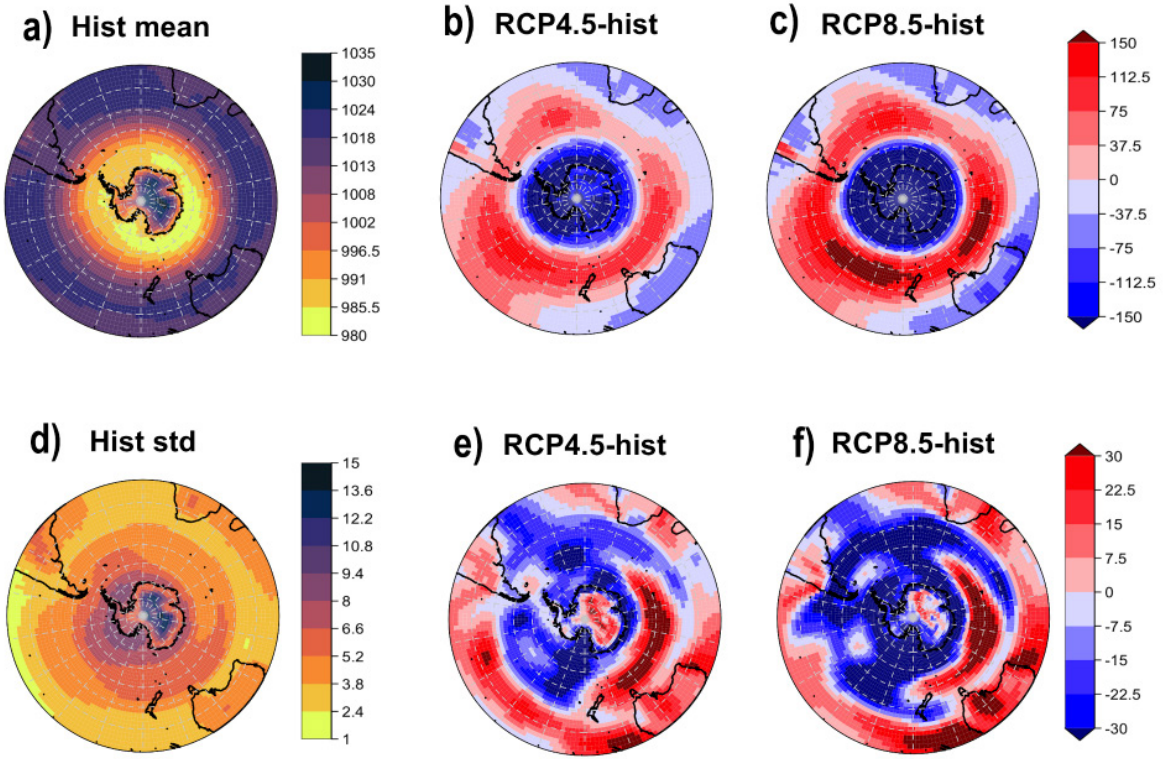
Figure 1. Mean sea level pressure in BESM-OA2.5 outputs: a) Historical mean (1850-2005); b) RCP4.5 and historical mean difference; c) RCP8.5 and historical mean difference; d) Historical mean variability; e) RCP4.5 and historical mean difference in variability; and f) RCP8.5 and historical mean difference in